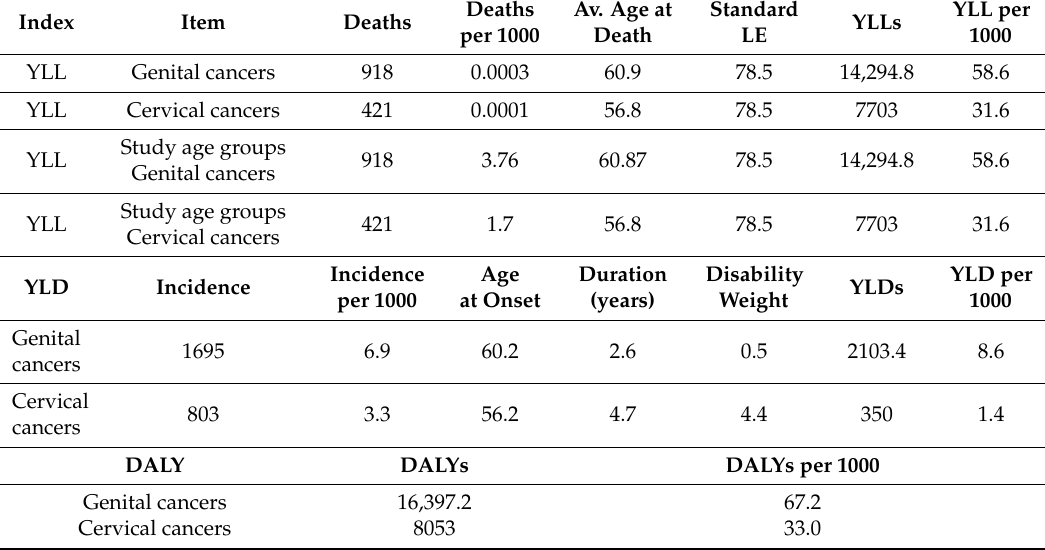
Table 5. YLL, YLD, and DALY in women aged 20–85 and over by genital cancer, Arad,